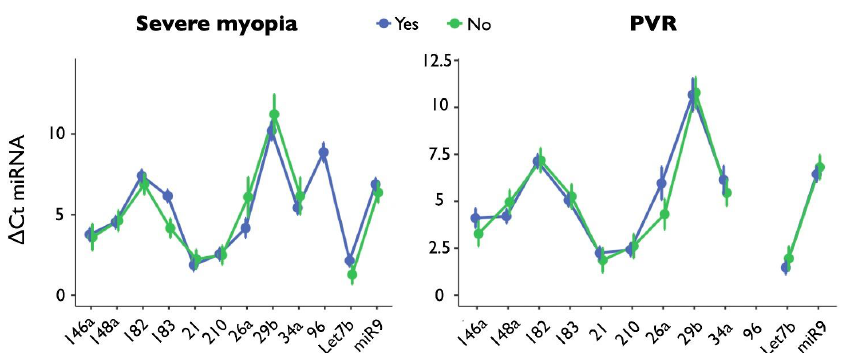
Figure 2. The graphs show miRNA expression stratified by severe myopia (on the left ) or PVR (on the right ); the 12 miRNAs are reported on the x -axis. Blue lines refer to the presence, while green lines indicate the absence, of myopia or PVR. For PVR, miR-96 values are missing because all the analyses in this group resulted in undetermined values. Under physiological conditions, active and passive forces promote normal adhesion between the neuroretina and the RPE. Rhegmatogenous retinal detachment is a condition in which fluid passes from the vitreous cavity into the subretinal space through a full- thickness retinal break, causing separation of the neuroretina from the underlying pig- ment epithelium. The most frequent pathological sequence in RRD involves vitreous liq- uefaction followed by posterior vitreous detachment, which in turn can cause a retinal tear at a site of tight vitreoretinal adhesion. We believe that the study of the SRF is im- portant to understand the biological mechanisms triggered by retinal detachment, as the SRF composition might reflect the events occurring after the neuroretina separates from the pigment epithelial cells. Therefore, we focused our attention on a new class of gene expression regulators, miRNAs. The role of miRNAs as therapeutic targets or as disease markers is an active area of research. Indeed, in a recent pilot study, the expression of 754 miRNAs was evaluated in the vitreous humor of patients affected by PVR, identifying the altered expression of 20 miRNAs in the vitreous of patients with RD and different grades of PVR [11]. The authors identified 20 miRNAs with altered expression in one or more pathological groups; between these, they found let-7b-5p and miR-21-5p. The expression profiles of vitreous miRNAs in patients with PVR were compared to the profiles of those in unaffected individuals, demonstrating that different miRNAs can be used as molecular biomarkers for the disease. In this study, for the first time, we showed the existence of possible correlations with PVR risk factors, as well as the existence of different expression profiles of miRNAs among patients with RRD with and without PVR. In fact, in the present study, we analyzed the expression profiles of a specific subset of miRNAs, reported in the literature as associated with the development of retinal fibrosis and angiogenesis [6,8,12 – 14]. Increased expres- sion levels of miR-21 showed significant correlations with time from symptom onset to RRD surgery and with the number of retinal breaks. miR-21 has been shown to play a crucial role in a myriad of biological functions, including cardiovascular disease and in- flammation. Lipopolysaccharide activates miR-21 expression in AEPR-19 cells and miR- 21 in turn promotes the production of inflammatory cytokines such as MCP-1 and IL-6 [15]. Furthermore, miR-21 expression is often correlated with tumor progression in vari- ous cancer types [16] and fibrosis [17,18], and its pro-oncogenic and profibrotic role during disease progression has been reported. Conversely, down-regulation of miR-21 in AEPR-